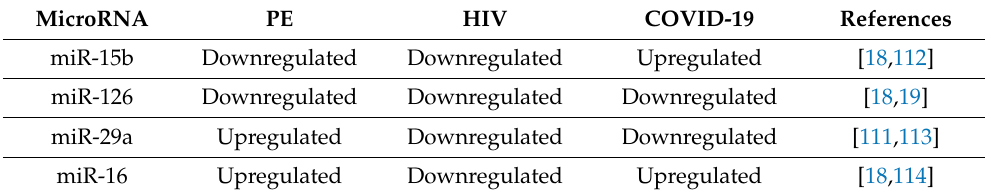
Table 1. The expression of VEGFR-2-related microRNAs commonly dysregulated in PE, HIV infection, and